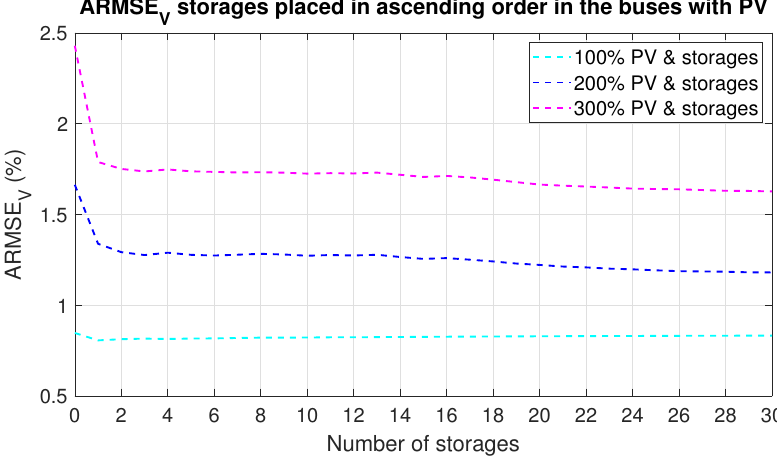
Figure 9. ARMSE of voltage across all buses and over a week for storages deployed in ascending